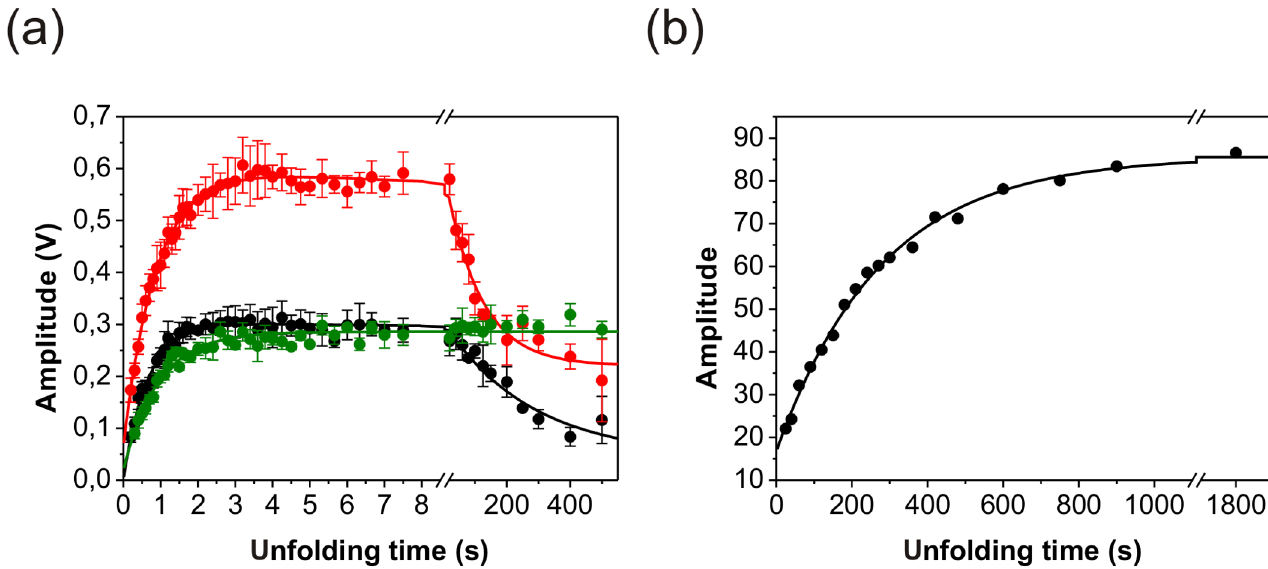
Fig 8. Double mixing unfolding kinetics of N-BAR (U assay). The amplitude plot for the fluorescence detected double mixing experiments reports about the time course of state during unfolding of N-BAR. (a) The colors of the three amplitude traces correspond to the colors of λ 1 (green), λ 2 (red), and λ 3 (black) in Fig 4. The protein concentration was 1 μ M finally. The continuous lines correspond to a single-exponential (green line) or double-exponential fit (red and black line) of the respective refolding phase. (b) Amplitude plot of the slowest refolding phase ( λ 4 ) against the unfolding time (manual